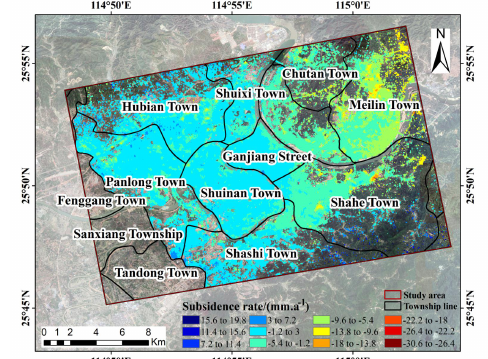
Figure 4. Surface subsidence rate in the study area from